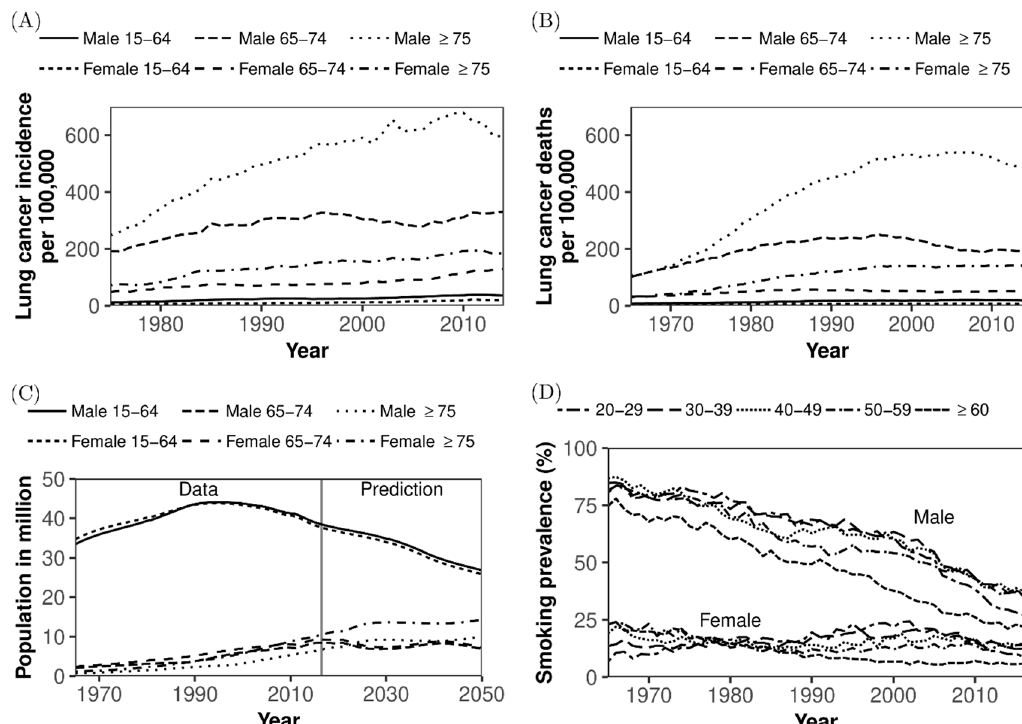
Figure 1. Incidence and mortality of lung cancer and the demographic dynamics and smoking prevalence in Japan. Published data of lung cancer incidence and mortality and the demographic dynamics and smoking prevalence in Japan. ( A ) Incidence of lung cancer by age group and sex per 100,000 population, ( B ) Mortality due to lung cancer by age group and sex per 100,000, ( C ) Age distribution of the population by sex, and ( D ) Prevalence of smokers by age group and sex.